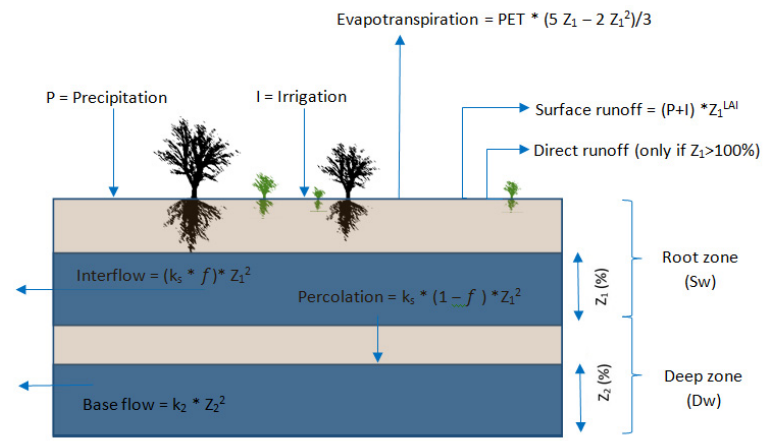
Figure 2. Soil moisture distribution (adapted from Yates,